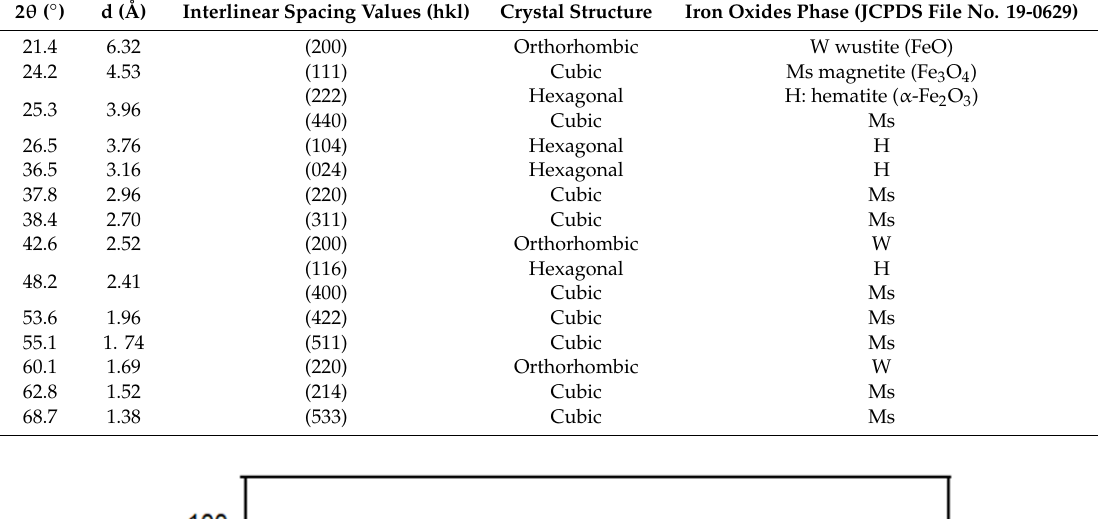
Table 1. X-ray diffraction positions (2θ) and crystal structure of the iron oxide phases identified. Table 1. X-ray di ff raction positions (2 θ ) and crystal structure of the iron oxide phases identified. 2θ (°) 2 θ ( ◦ )